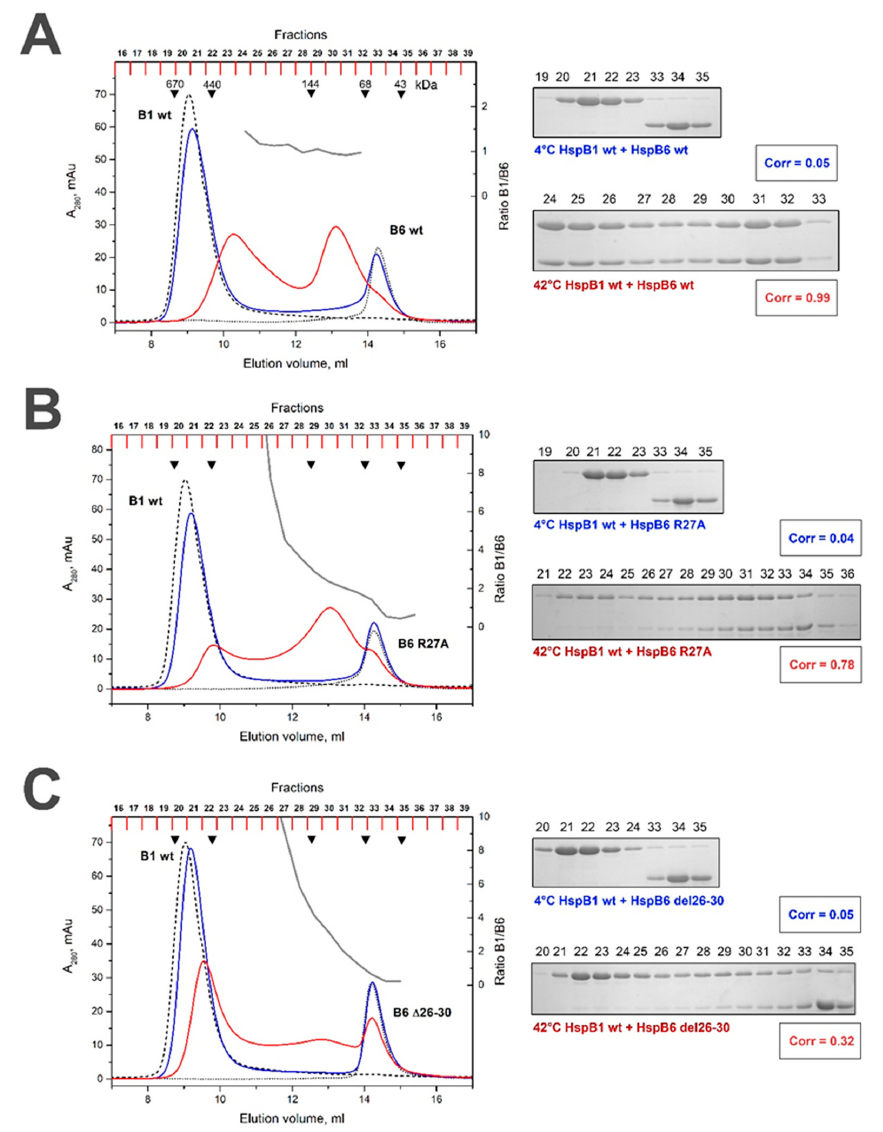
Figure 4. Size-exclusion chromatography of the WT HspB6 (A) , its R/A (B) and Δ (C) mutants and their mixtures with the WT HspB1. The elution profiles of isolated HspB6 or its mutants are shown as a black dotted line, that of isolated WT HspB1 by a black dashed line. The elution profile of the mixture of HspB6 species and WT HspB1 preincubated at low temperature is shown as a solid blue line and that of the corresponding mixture preincubated at elevated temperature is shown as a solid red line. The molar ratio HspB1/HspB6 (grey solid line) in the corresponding fractions obtained after chromatography of preheated sample is indicated on the right ordinate. The protein composition of the fractions obtained after the chromatography of HspB1/HspB6 mixture preincubated at low (labeled blue) or high (labeled red) temperature are presented on the inserts. The correlation coefficient (Corr) is indicated under each electropherogram. The numbers above tracks correspond to the fractions number. Apparent molecular weights are indicated by arrows. The WT HspB5 and its R/A or Δ mutants formed large stable oligomers with apparent molecular weights of 510–550 kDa [35]. At low temperature the WT HspB5 was unable to form heterooligomeric